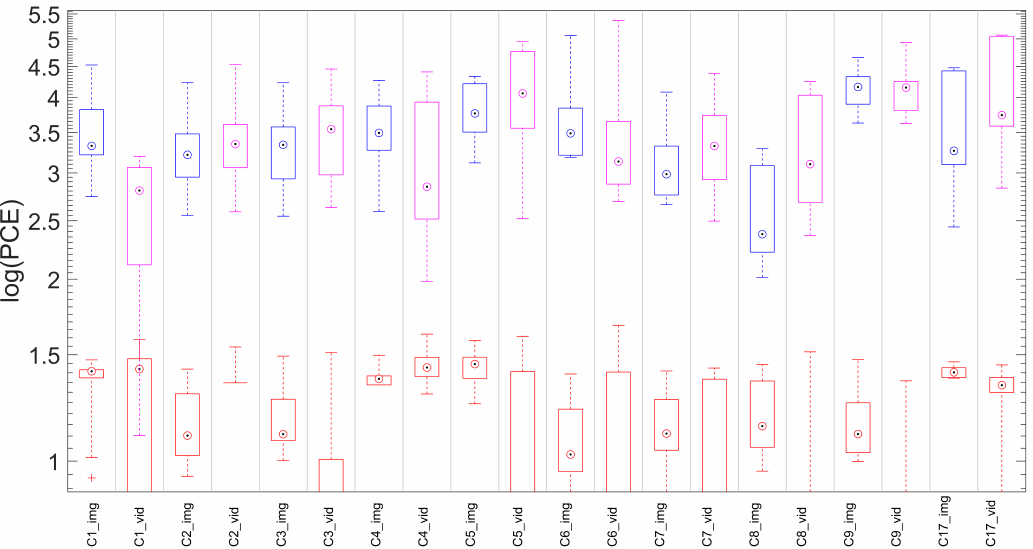
Figure 4. (Best viewed in color) Matching statistics mP I and mP V are represented by the blue and pink boxplots, respectively. Corresponding mismatching statistics in red. On each box, the central mark indicates the median, and the bottom and top edges of the box indicate the 25th and 75th percentiles, respectively. The whiskers denote the minimum and maximum of the statistics. For plotting purposes, we defined log ( a ) = − ∞ , ∀ a ≤